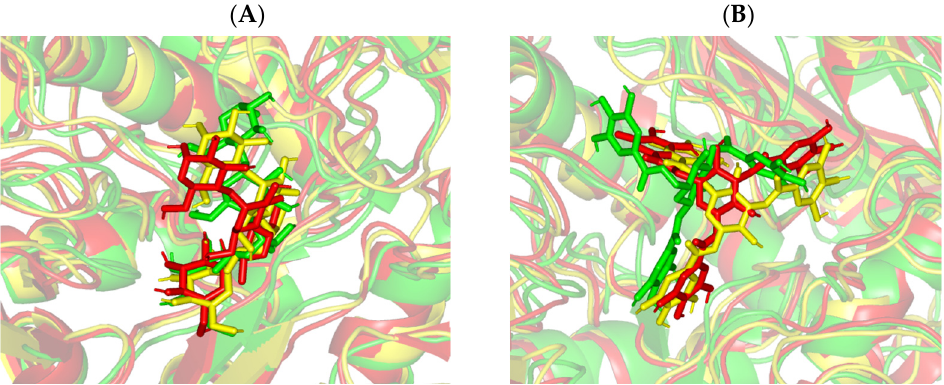
Figure 8. Conformational analysis of simulated ligand-hMGAM complexes at the initial, middle, and final snapshots. Overlaid snapshots of the ligand-protein complexes; ( A ) acarbose; ( B ) 1,3,6-trigalloylglucose, at 0 ns, 100 ns, and 200 ns MD simulation frames. The target proteins are represented in green, yellow, and red cartoons corresponding to the initial, midway, and last extracted frames, respectively. Ligands (sticks) are presented in colors corresponding to their respective extracted frames.